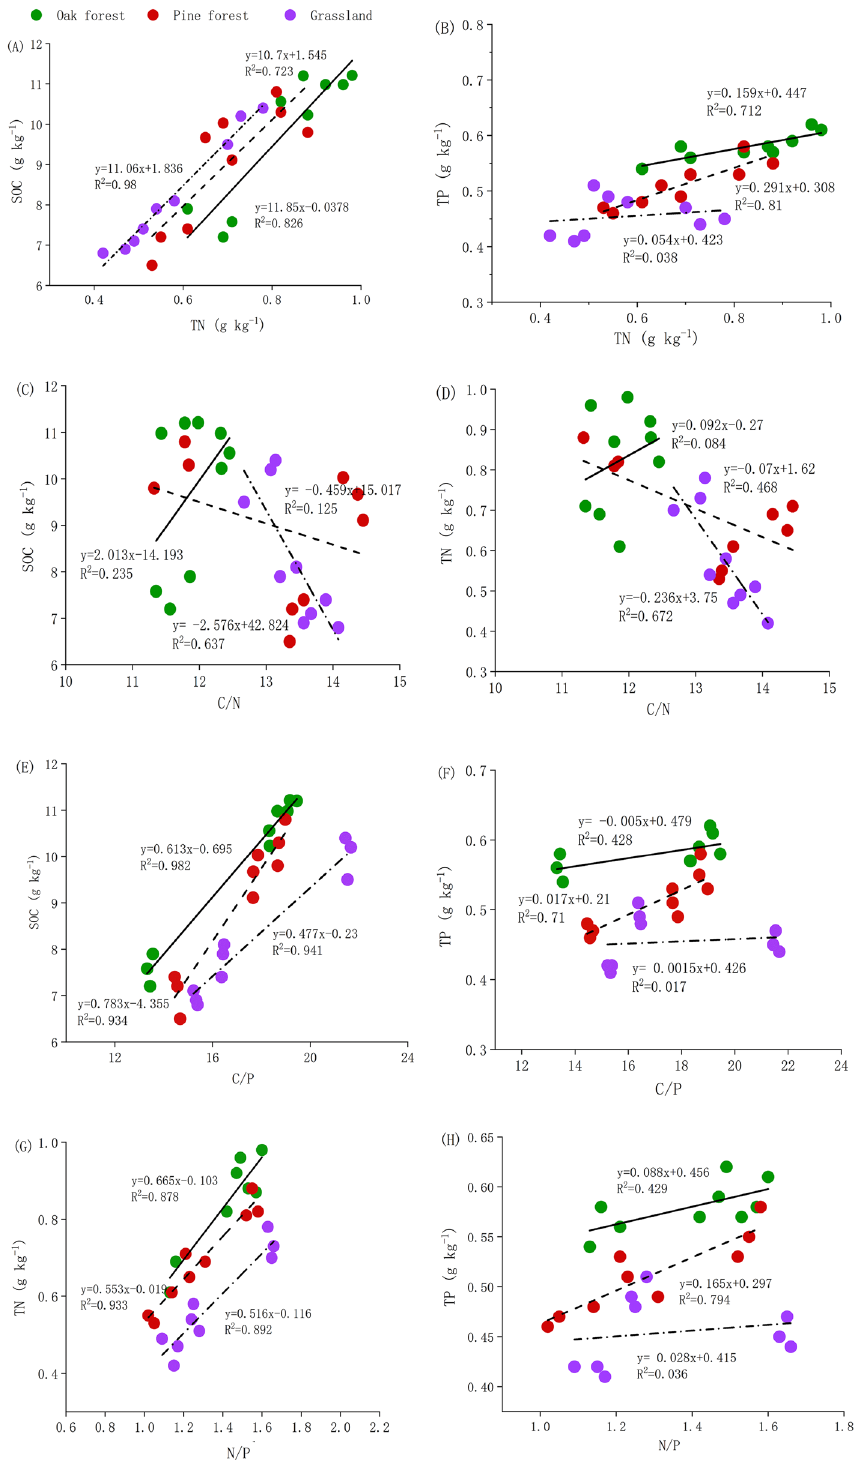
Figure 4. Relationships between TN and SOC (A), TN and TP ( B ), C/N and SOC ( C ), C/N and TN ( D ), C/P and SOC ( E ), C/P and TP ( F ), N/P and TN ( G ), N/P and TP ( H ) stoichiometry ratios, respectively (p <